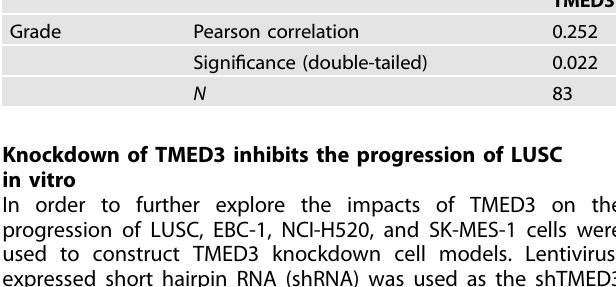
Table 3. Relationship between TMED3 expression and tumor characteristics in patients with lung squamous cell carcinoma.